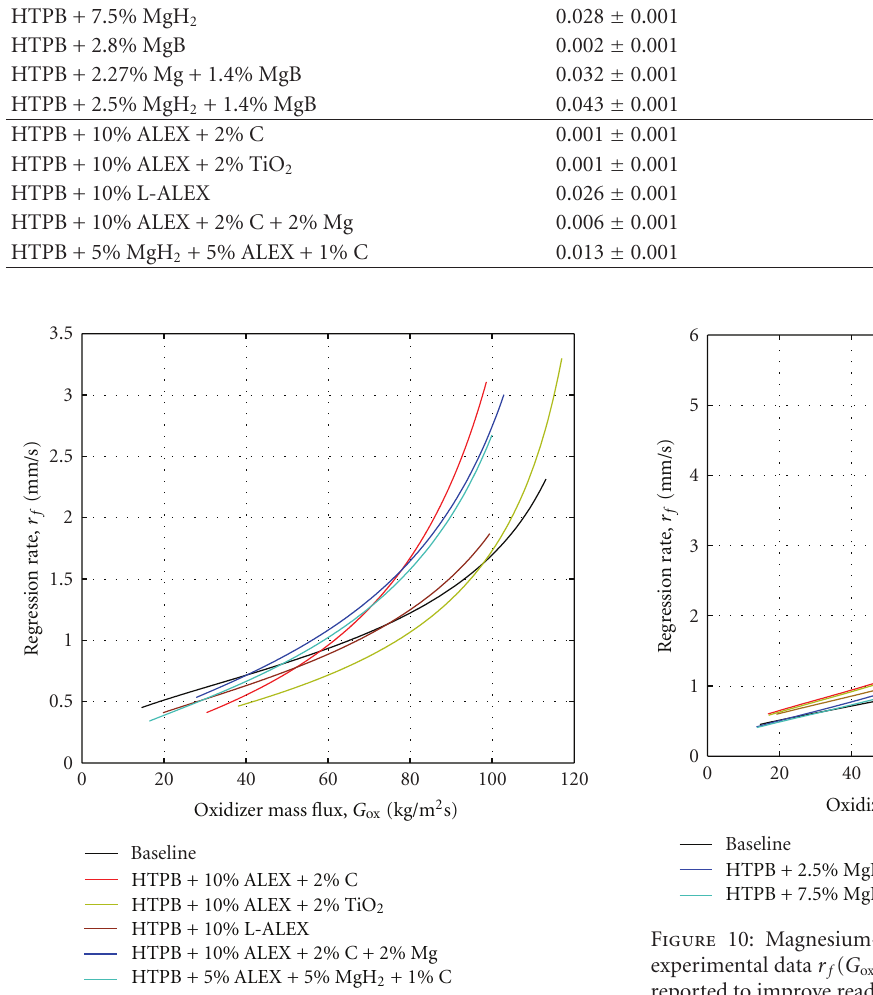
Figure 9: ALEX-loaded formulations: ensemble average, exper- imental data r f ( G ox ) compared to baseline. Error bars are not reported to improve readability.